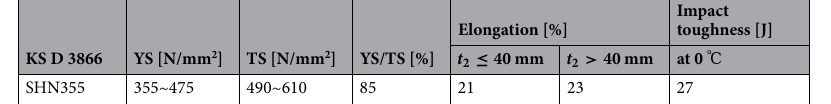
Table 3. Mechanical characteristics of SHN355 in KS D 3866 standard.